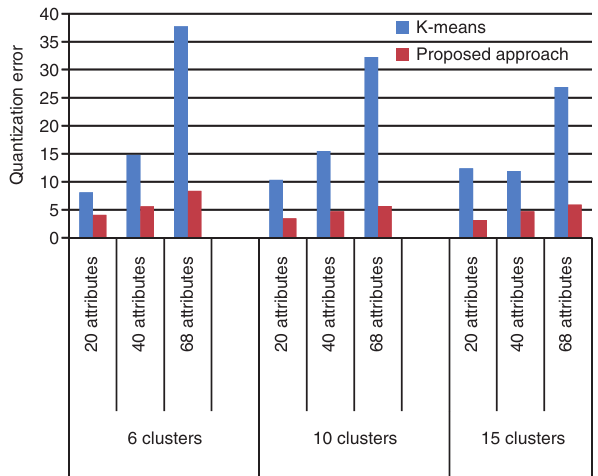
Figure 5: Comparison of Obtained Results for Uscensus Dataset Based on Quantization Error.